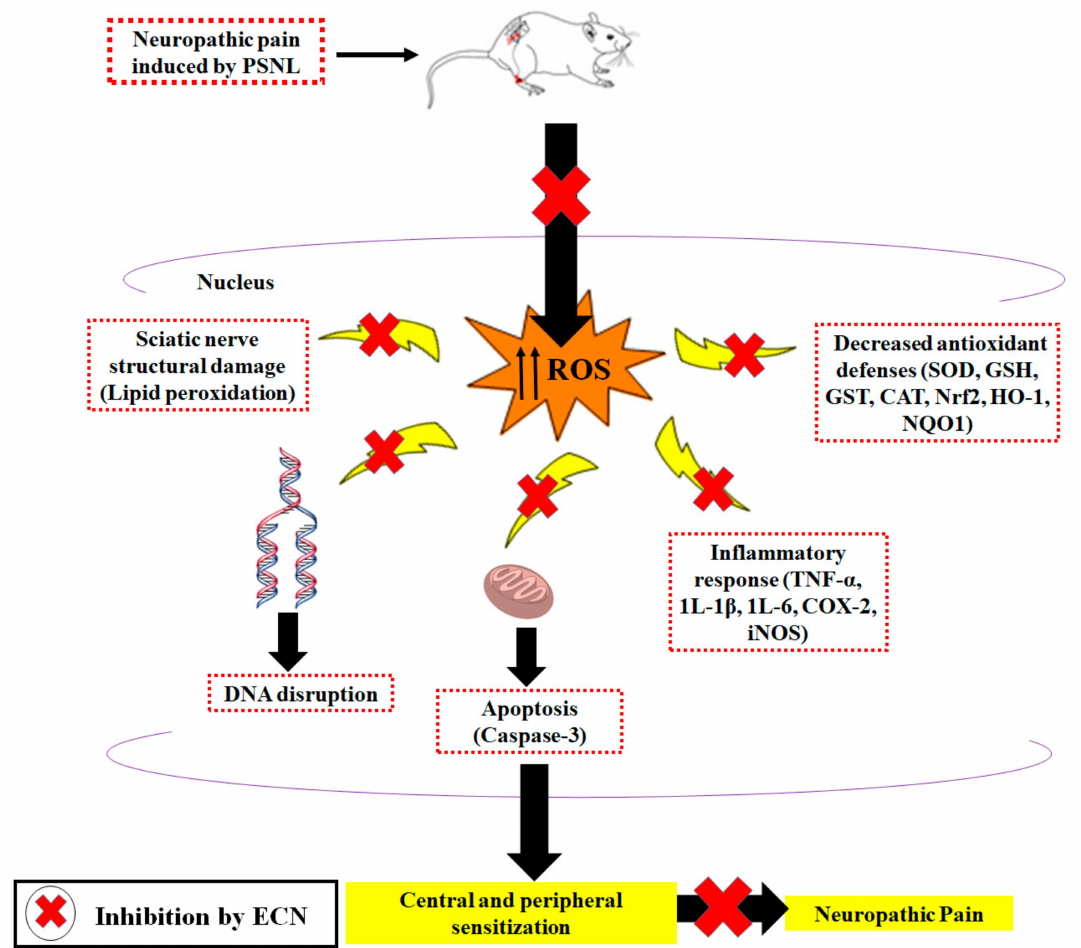
Figure 13. Proposed mechanism of the anti-neuropathic effect of ECN in the PSNL model.